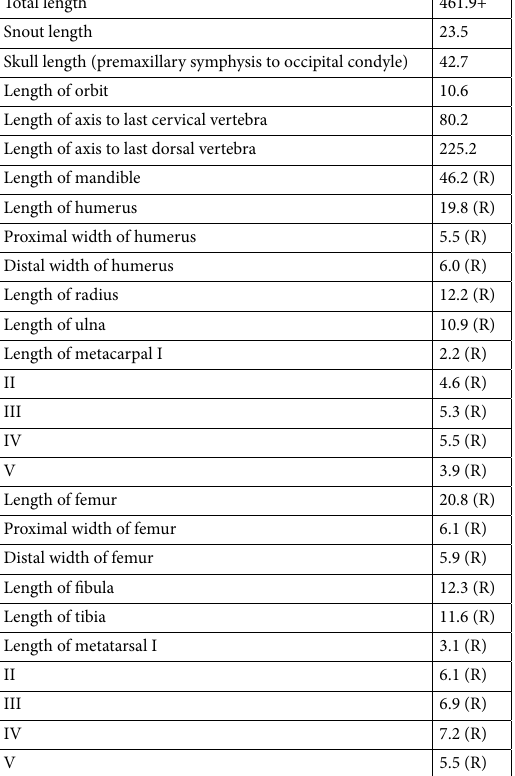
Table 1. Measurements (in mm) of the holotype (IVPP V19049) of Luopingosaurus imparilis gen. et sp. nov. R,